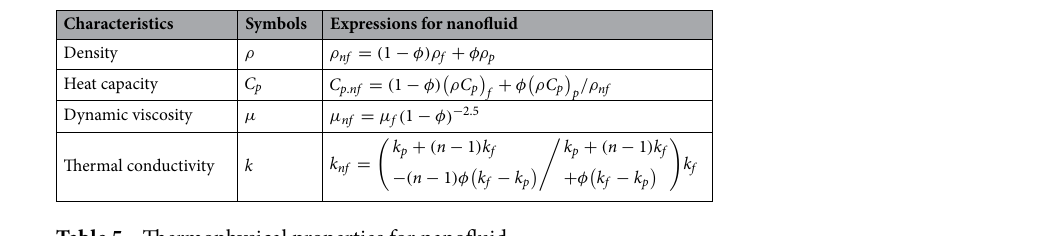
Table 5. Thermophysical properties for nanofluid.